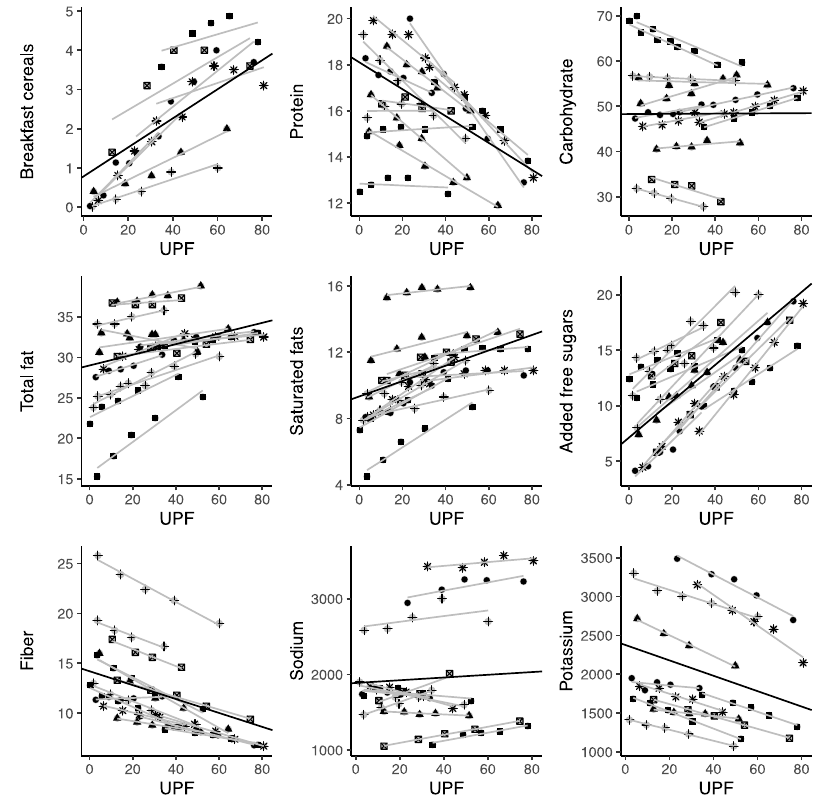
Figure 2. Scatter plots for the correlation between ultra-processed food consumption and selected food items in nationally representative samples. Symbols represent different cohorts; light lines represent linear regression coefficients of individual studies; bold lines represent summary estimates of the average variation in each food item for a 1% increase in ultra-processed food intake (as a percentage of daily energy).